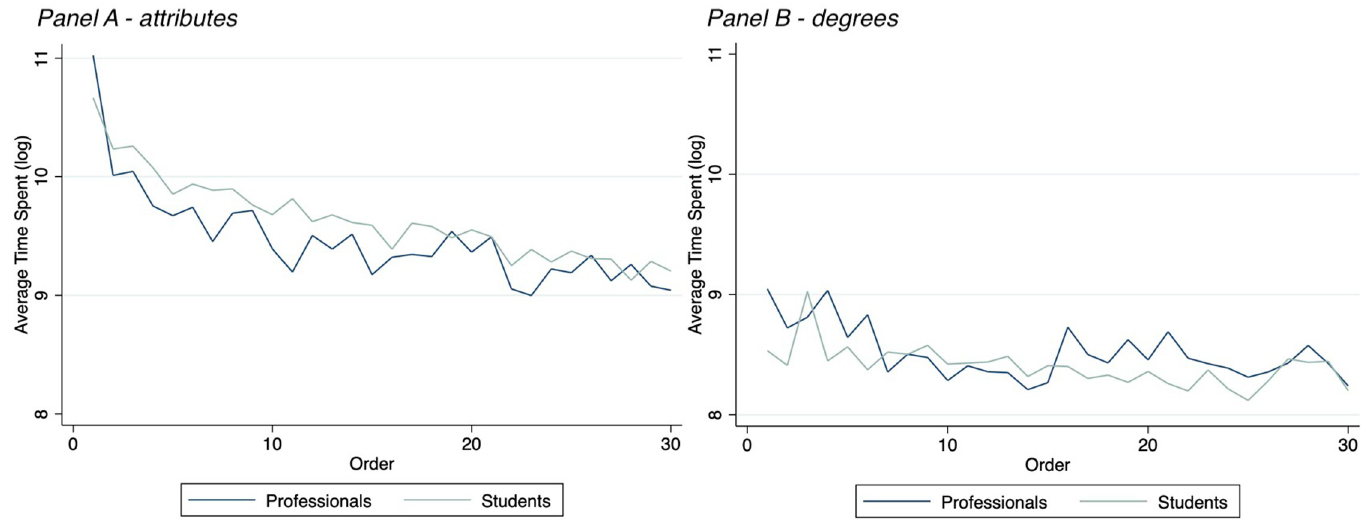
Fig 1. Attention. Pattern of attention measured in time spent (seconds) for attributes (Panel A) and degrees (Panel B) over the 30 repeated collaboration scenarios, by professionals and students. The logarithmic form of the variable of interest is depicted in the graph.